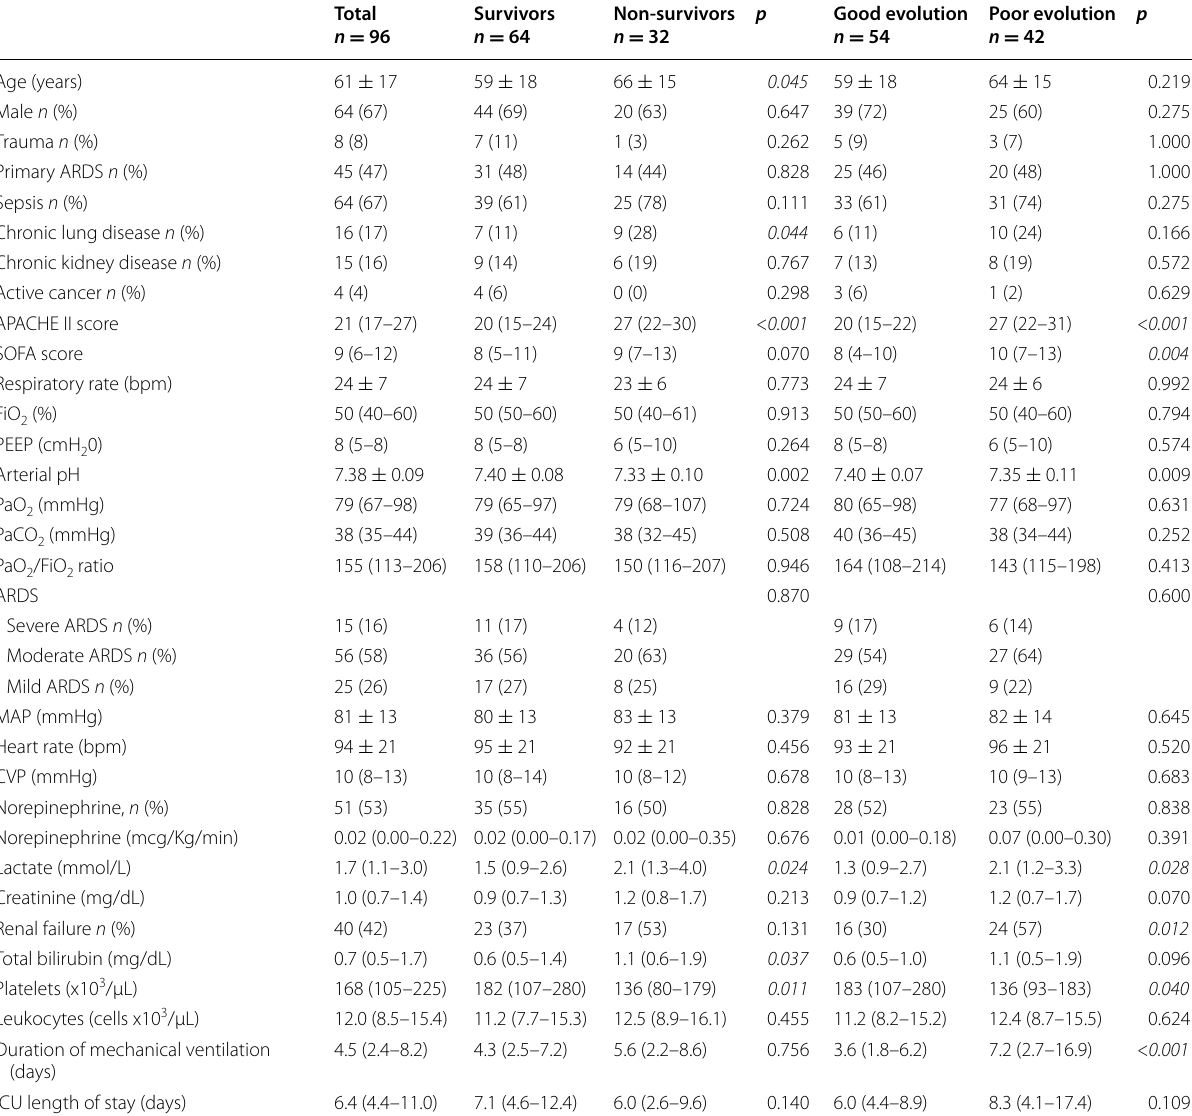
Table 1 Main characteristics (at time of inclusion) and outcomes of the patients with